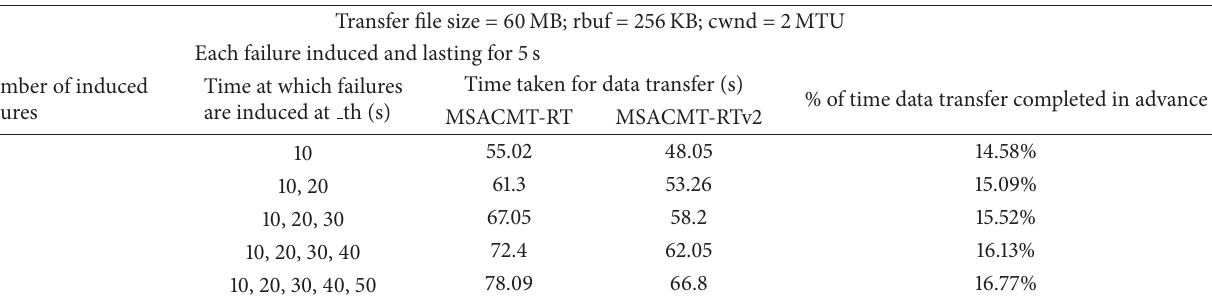
Table 2: Overall data transfer time